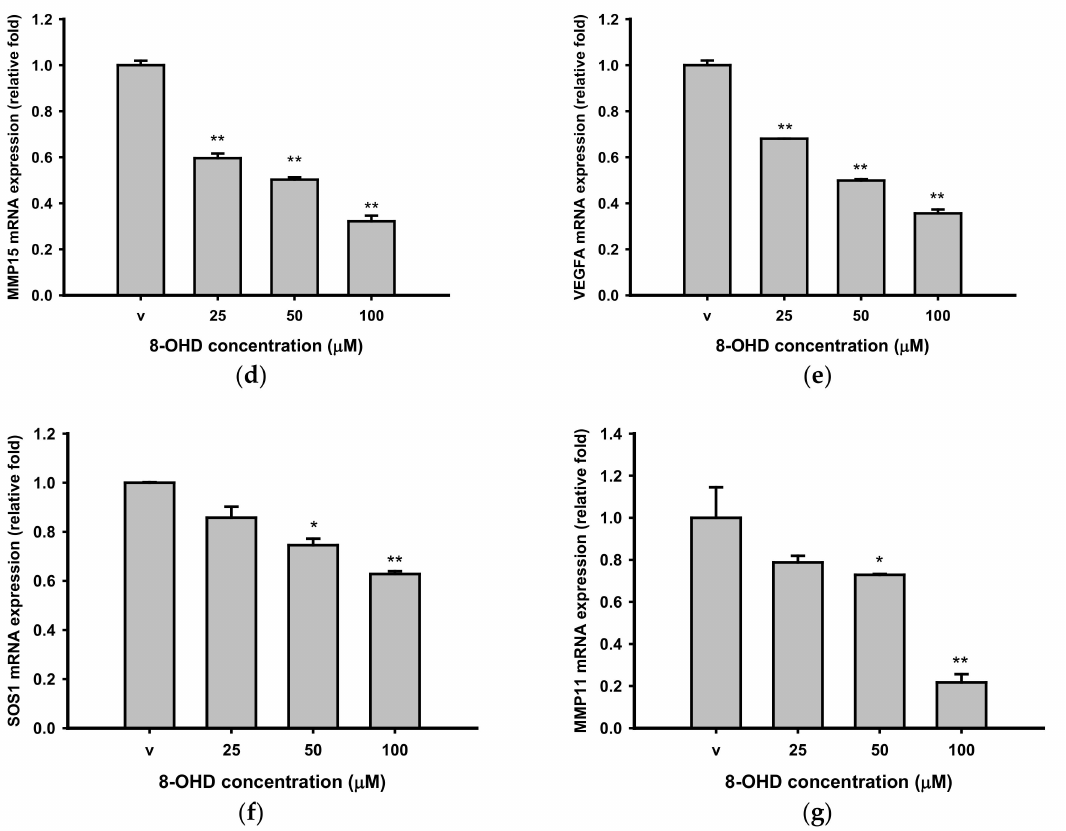
Figure 4. 8-OHD repressed matrix metalloproteinase (MMP) expressions. ( a ) The MetaCore pathway map of the “Role of metallo- proteases and heparanase in progression of pancreatic cancer” obtained by functional analysis of 1910 downregulated differentially expressed genes (DEGs) in response to 8-OHD. The blue thermometer indicates downregulated genes, and the thermometer level represents the intensity of the log 2 (fold change). The image was generated using MetaCore. ( b ) Heatmap of expression patterns of MMP-associated genes in response to 8-OHD. H5 and H1 represent 50 and 100 µ M 8-OHD, respectively. ( c – g ). Reconfirmation of MMP-associated genes by RT-qPCR. * p < 0.05 and ** p < 0.01 indicate significant differences compared to vehicle-treated